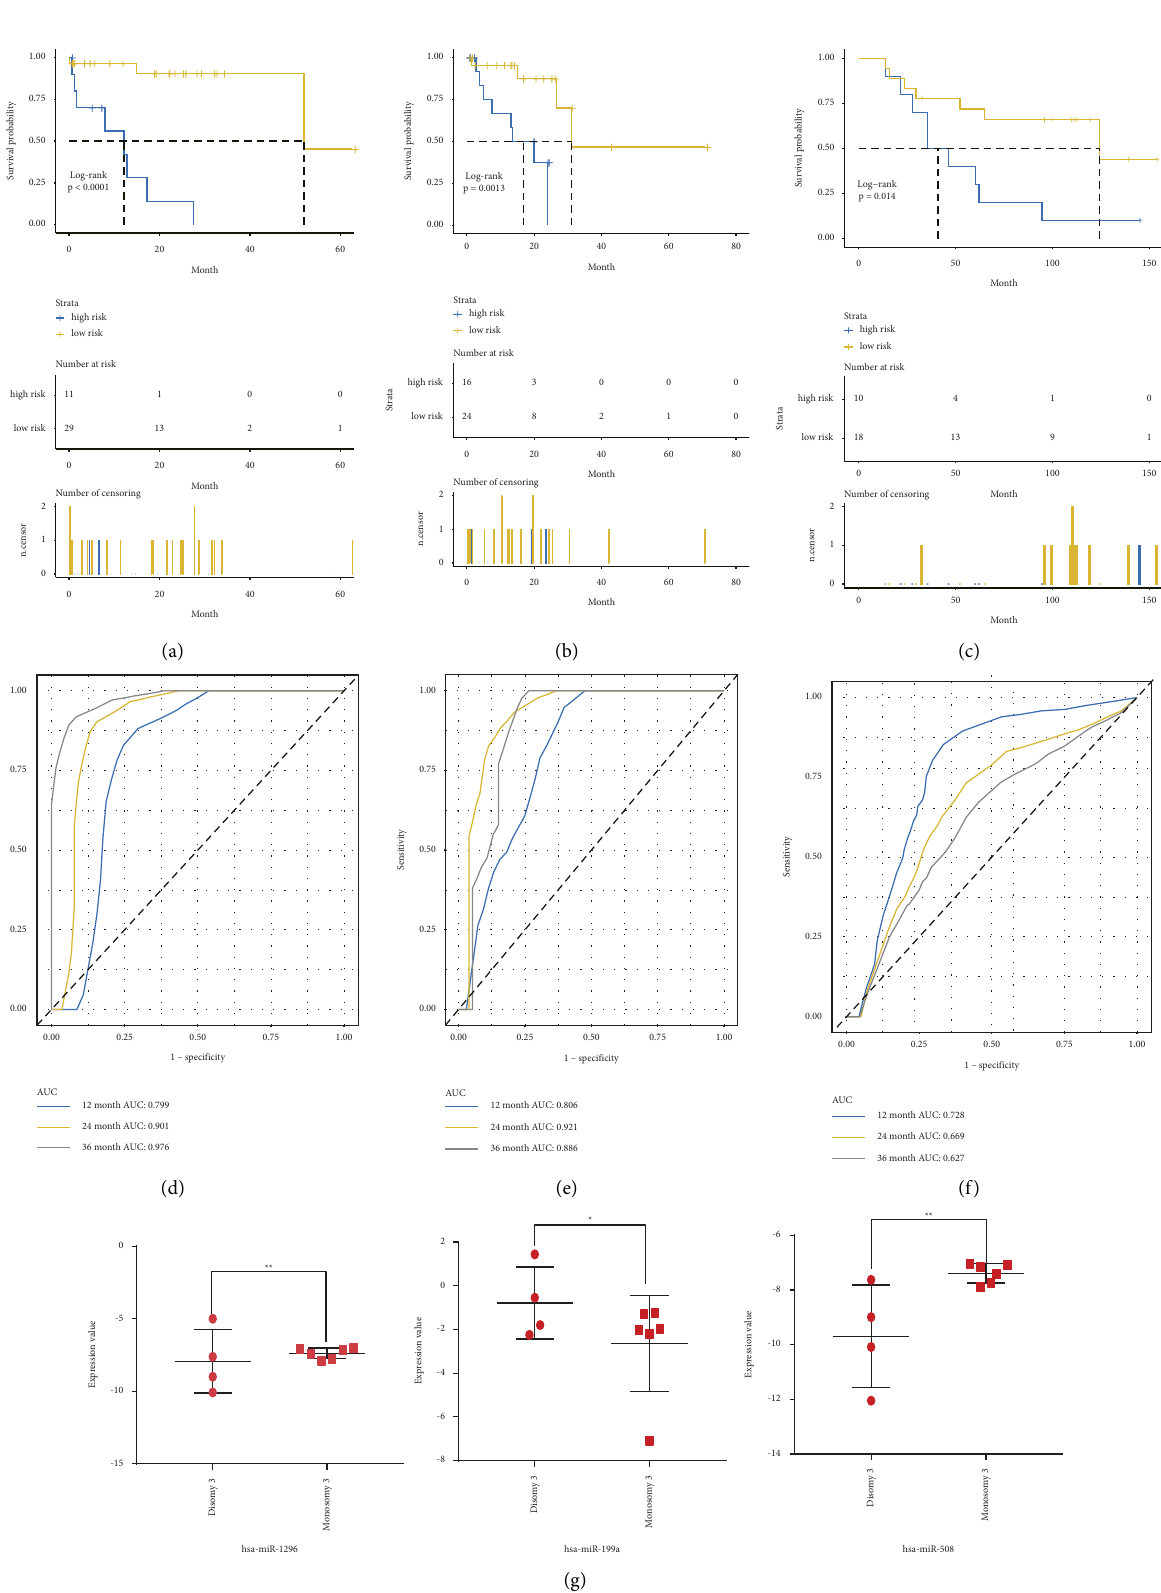
Figure 2: Kaplan–Meier curve survival analysis for 3-miRNA prognostic signature of uveal melanoma (UM). (a–c): Te Kaplan–Meier curve of the overall survival (OS) between the high-risk and low-risk groups stratifed by the median risk score in training, testing and GSE84976 datasets respectively. (d–f): Te receiver operating characteristic (ROC) curves of 3-miRNA in training, testing and GSE84976 datasets, respectively. (g): Te plot analysis of 3 miRNAs in GES68828 dataset. ∗ P < 0 . 05, ∗∗ P < 0 .